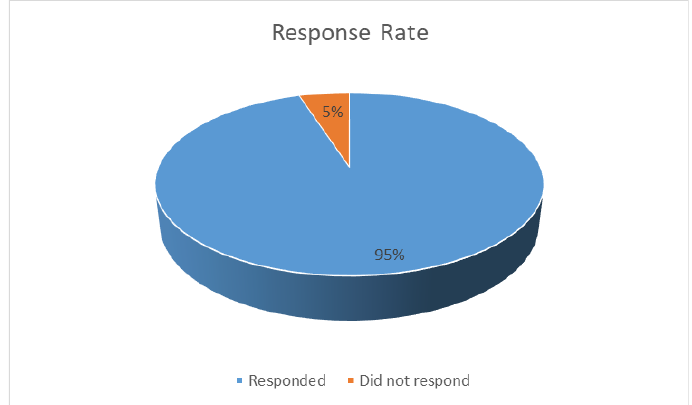
Figure 2: Response Rate